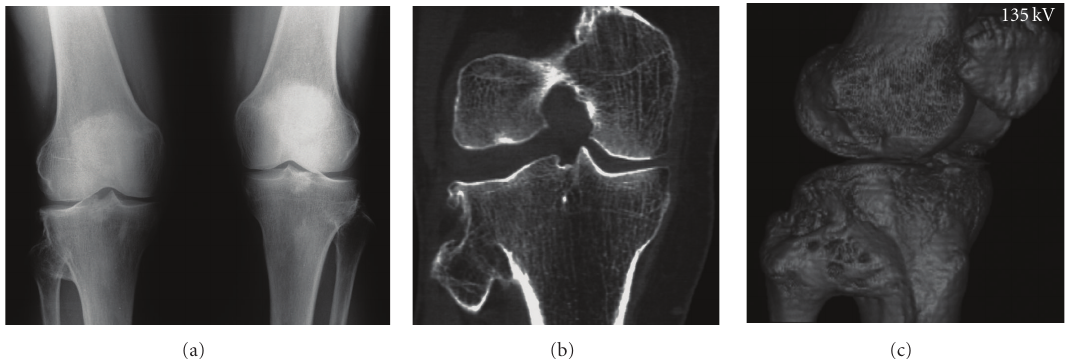
Figure 2: AP radiograph of both knees (a), CT (b) and 3D (c) examination, in a 60-year-old woman, showing synostosis of the proximal TFJ of the right